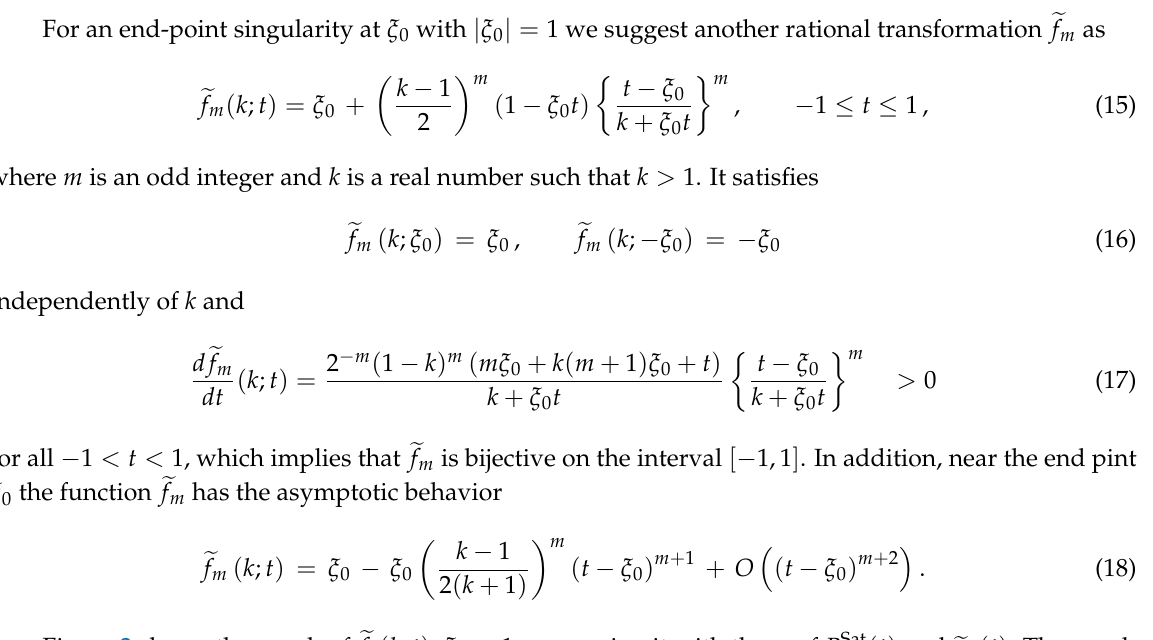
Figure 1. Graphs of the proposed rational transformations f m ( η ; t ) , η = s 0 , with respect to m = 3,5,7 in ( a ) and graphs of f 3 ( η ; t ) with respect to η 1 = s 0 , η 2 = s 0 /2, η 3 = s 0 /4 in ( b ) for the case of s 0 = 0.65.